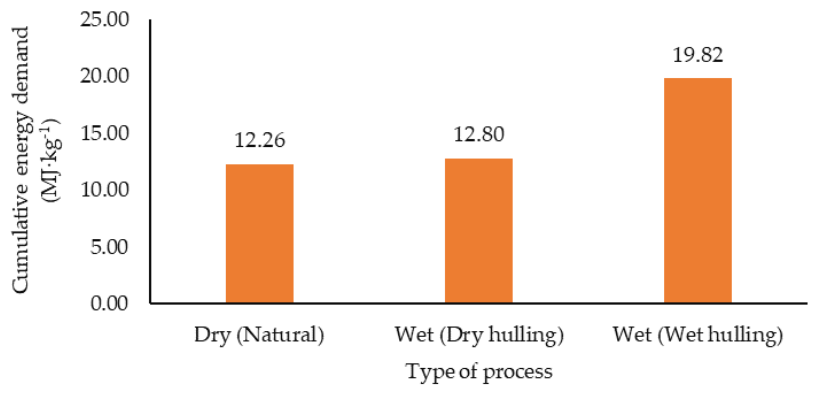
Figure 6. Cumulative energy demand (CED) of a 1 kg green coffee bean production .